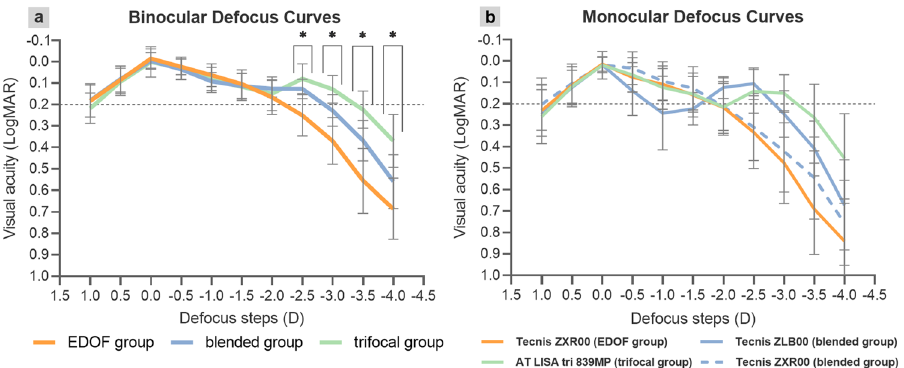
Figure 2. Binocular ( a ) and monocular ( b ) defocus curves of the EDOF, blended and trifocal groups. The binocular defocus range of the EDOF group, blended group and trifocal group was 2.5 D, 3.0 D, and 3.5 D, respectively. At vergence of − 2.5, − 3.0 and − 3.5 D, the binocular visual acuity of the EDOF group was statistically significantly worse than the blended group and trifocal group. At a vergence of − 4.0 D, the binocular visual acuity of the trifocal group was statistically significantly better than the EDOF group and blended group. All outcomes were compared between the three groups. Regarding the monocular defocus curves, the shape of curves showed the characteristic of AT LISA tri 839MP, Tecnis ZXR00 and Tecnis ZLB00 IOL design. Results are shown in logMAR notation, with reference to the 0.2 logMAR thresholds. * means statistically significant difference between three groups. logMAR logarithm of the minimum angle of resolution, D diopters.